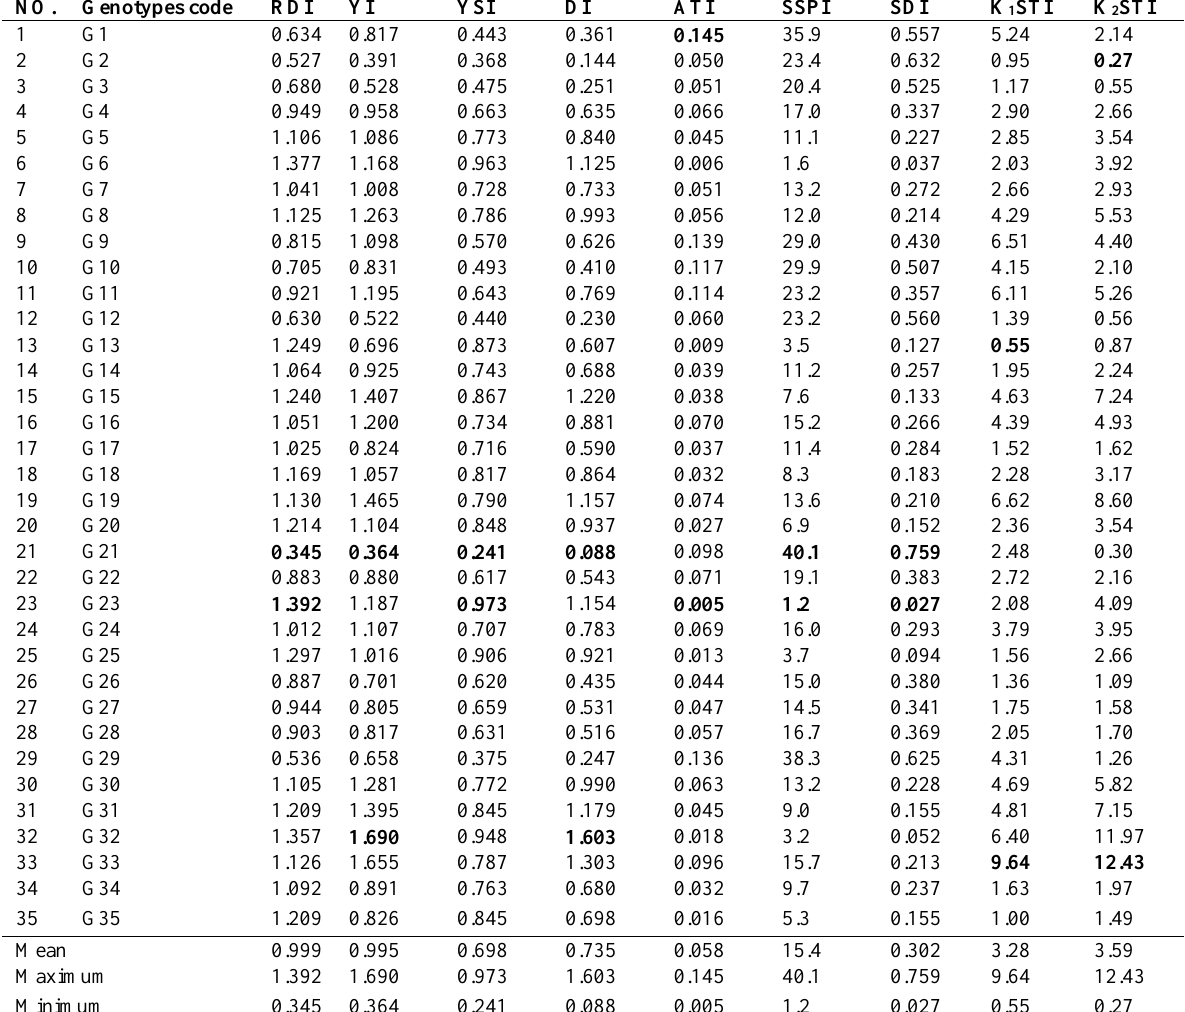
Table 4. New indices of zinc stress tolerance for 35 durum wheat